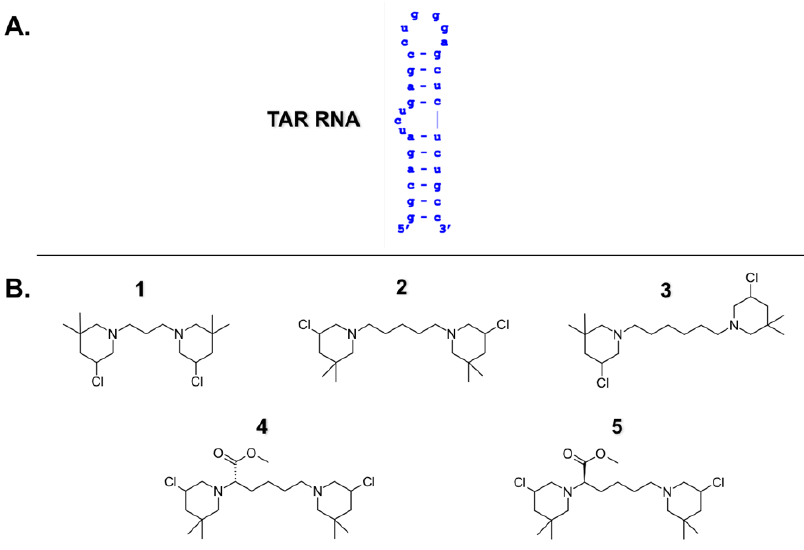
Figure 1. ( A ) Sequence and secondary structure of oligonucleotide-construct replicating trans- activation response (TAR) RNA which was employed in our assays. ( B ) Chemical structure of bis-3-chloropiperidines analyzed in this work.